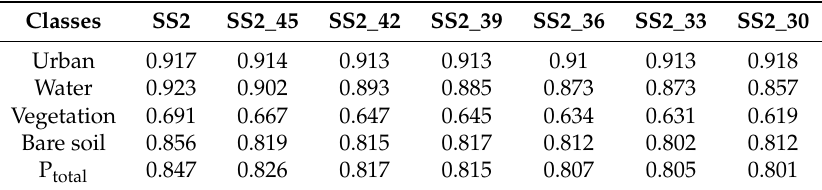
Table 26. Probabilities of correct classification depending on compressed image quality for Set 2, AGU coder, ML classifier.